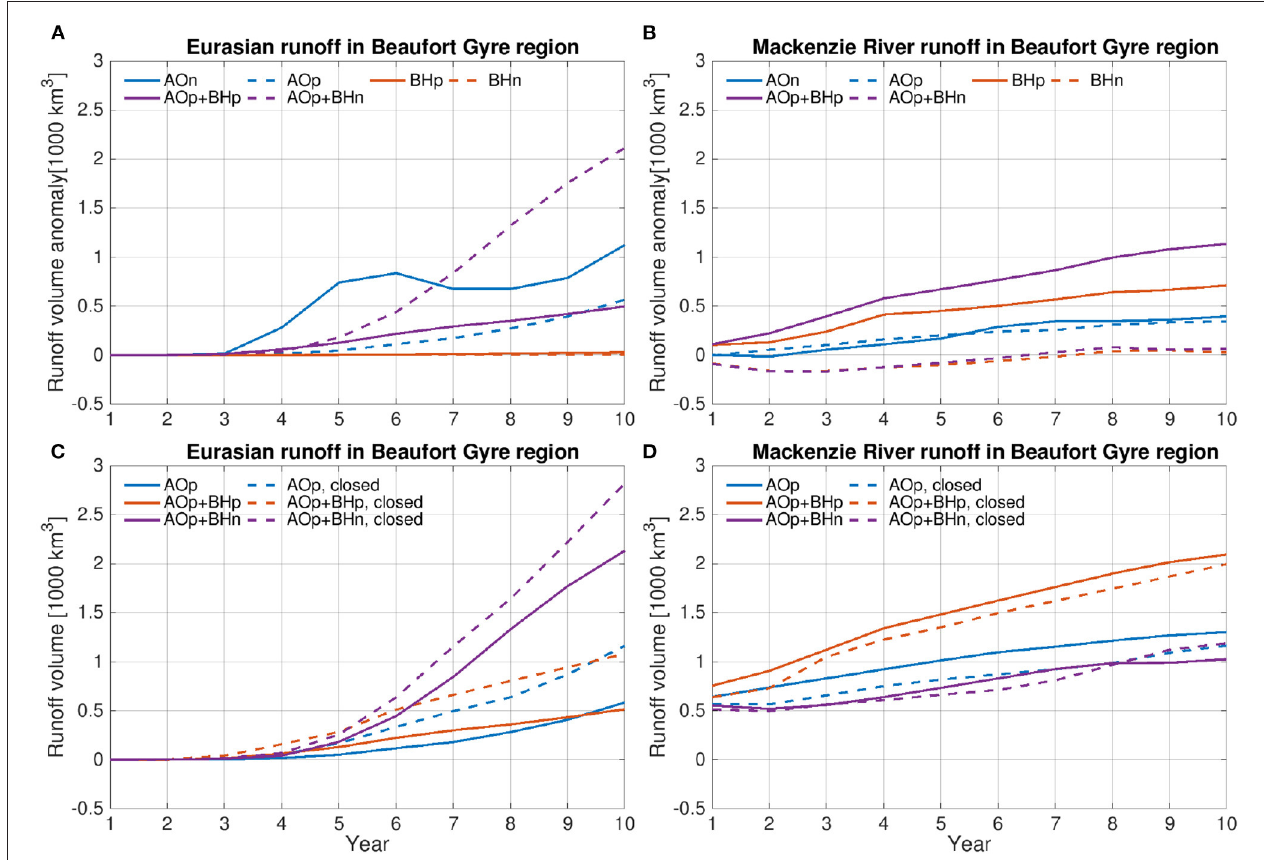
FIGURE 13 | Time series of the volume of (A) Eurasian runoff and (B) Mackenzie River runoff in the Beaufort Gyre region. The anomalies relative to the control run are shown. (C,D) River runoff volume in simulations with Bering Strait closed compared with those with Bering Strait open: Time series of the volume of (C) Eurasian runoff and (D) Mackenzie River runoff in the Beaufort Gyre